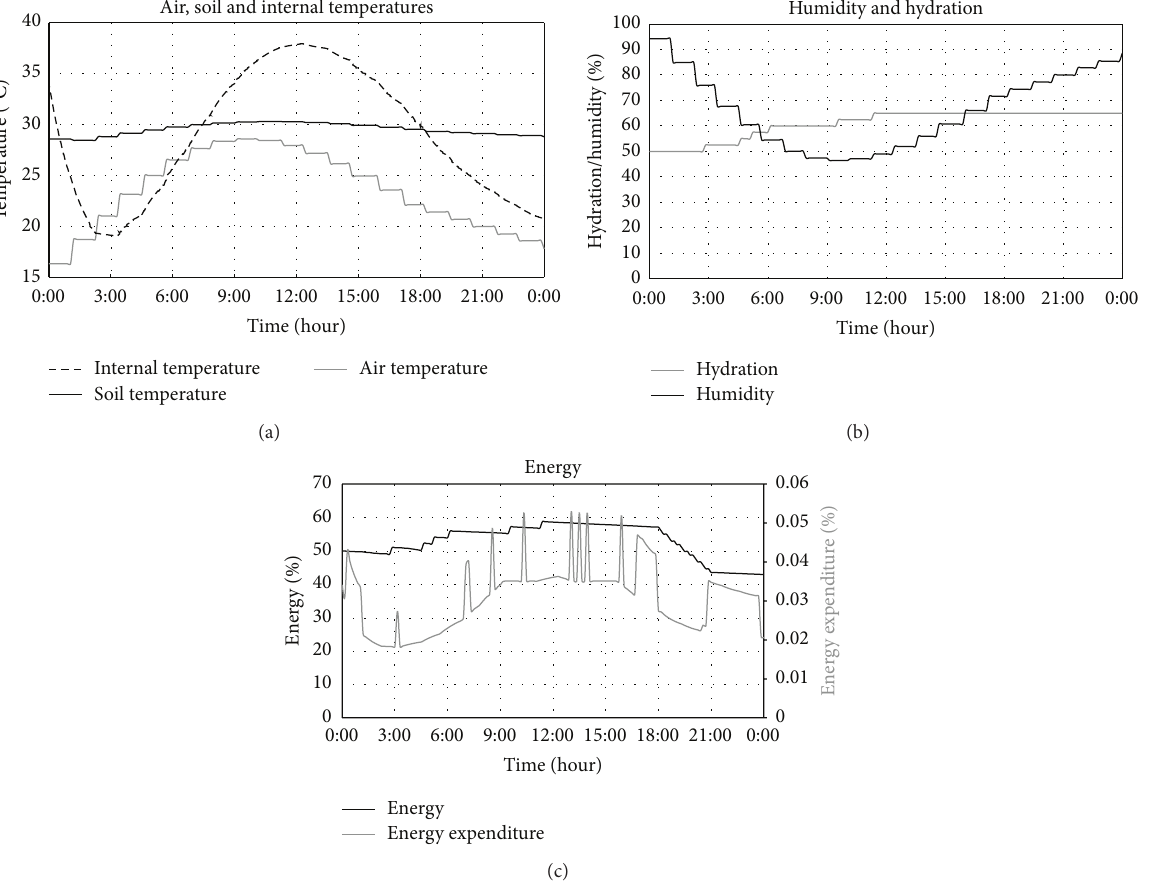
Figure 12: Graphs for a 24 h period of game simulation showing temporal variation in (a) temperatures, (b) hydration/humidity, and (c)